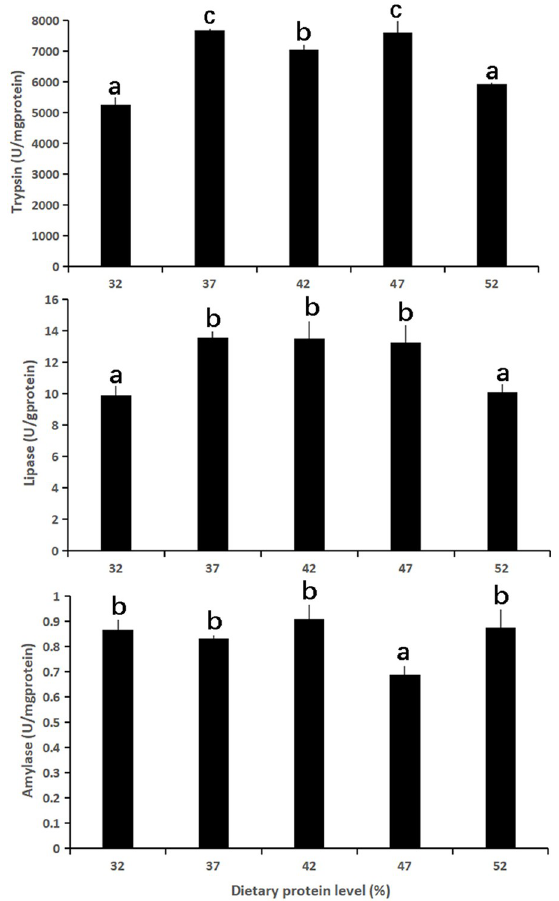
Fig 2. Specific activities of three digestive enzymes in the intestine of Culter mongolicus fed with varying dietary protein levels. Data presented are mean ± SE, different letters on the top of bars mean significantly different ( p <